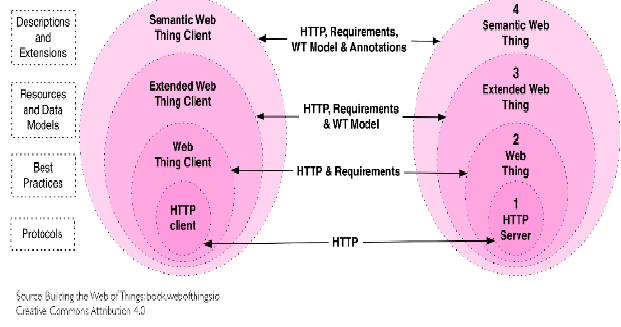
Fig. 3. Nutshell tool characteristics